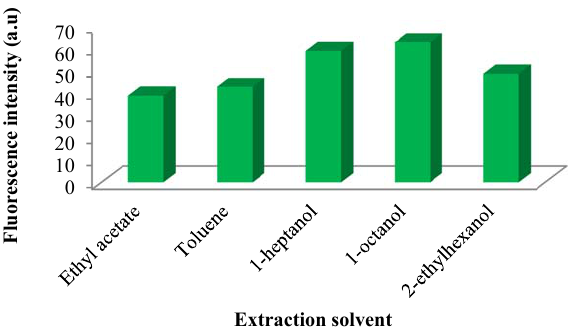
Fig. 7. Effect of extracting solvent on the recovery of ZEN. Conditions: dispersive solvent, 3 mL of MeCN/water (80:20 v/v); water volume, 15 mL, equilibration time, 60 s, adsorbent amount, 40 mg; adsorption time, 3 min; desorption time, 4 min, desorption solvent volume and type, 1 mL of